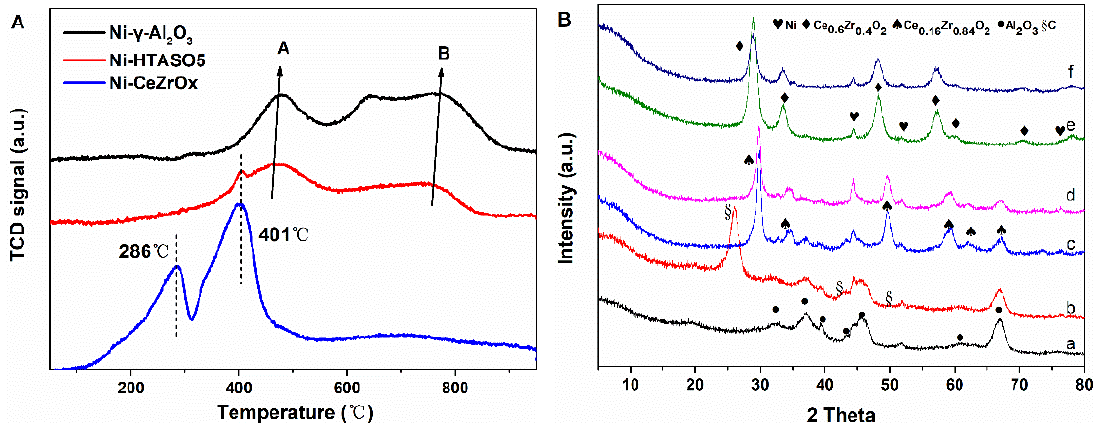
Figure 3. ( A ) H 2 -TPR profile and ( B ) XRD result of Ni-based catalysts with different supports: Ni- γ -Al 2 O 3 (a) after reduction (b) after reaction, Ni-HTASO5 (c) after reduction (d) after reaction and Ni-CeZrO x (e) after reduction (f) after reaction.